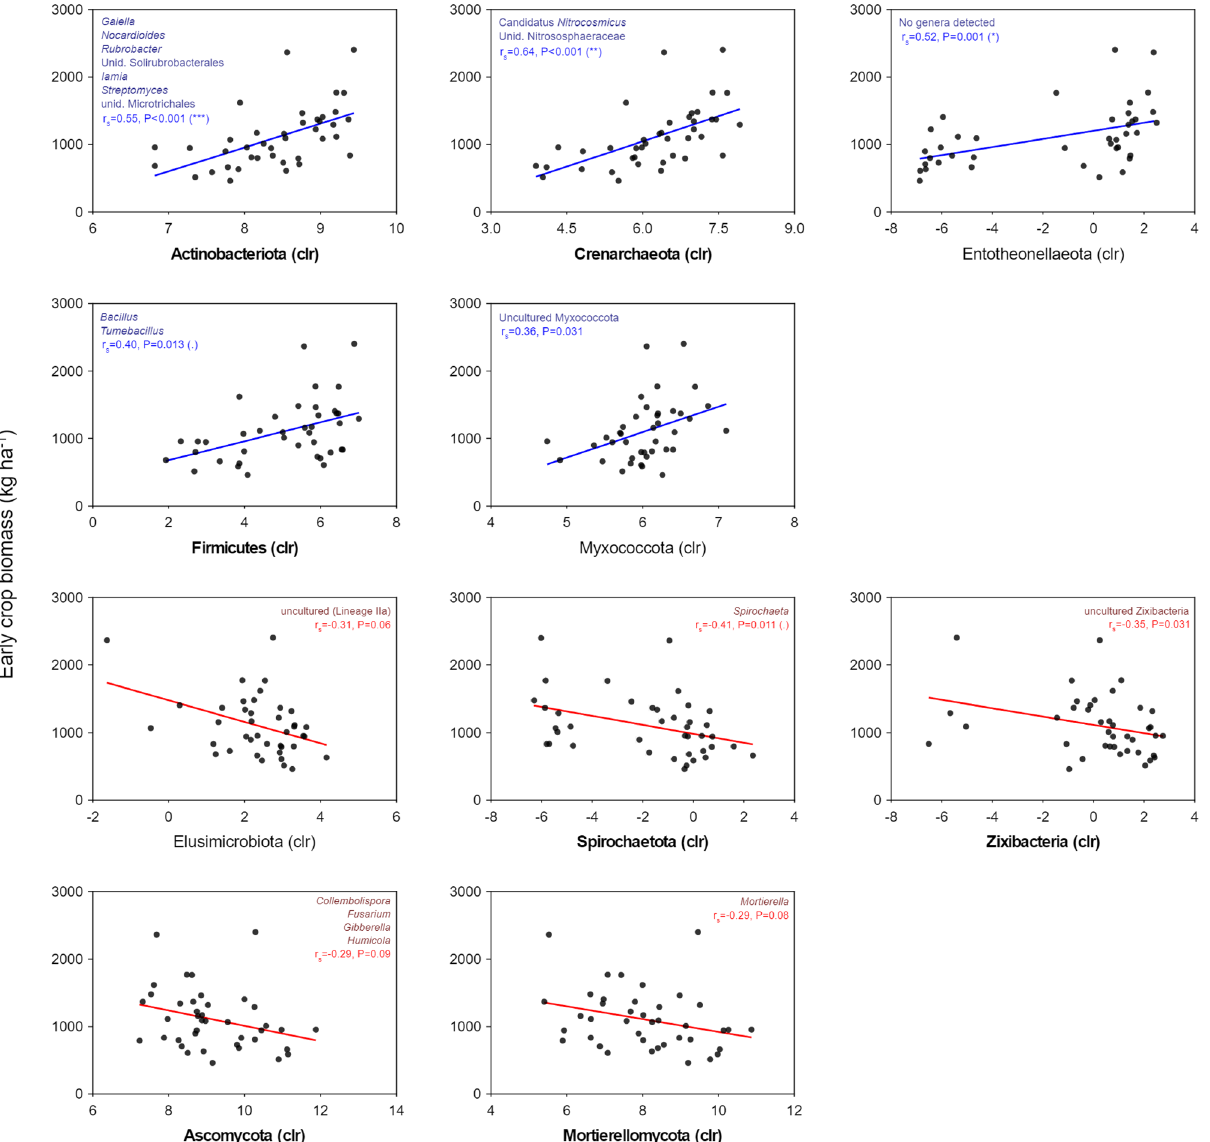
Figure 5. Soil prokaryotic and fungal phyla positively (blue) and negatively (red) correlated with early tomato growth in the following year. In each plot, Spearman correlation coefficients (r s ) and P values from ALDEx ( aldex.corr ) are shown. If applicable, genera correlated to early crop growth are shown within each phylum’s plot (see Table S7 for full id.). Phyla names in bold were also sensitive to CCs (see Fig. 2c,f). Symbols between brackets represent Benjamini–Hochberg corrected P values, when significant: ***< 0.001, **< 0.01, *< 0.05, <